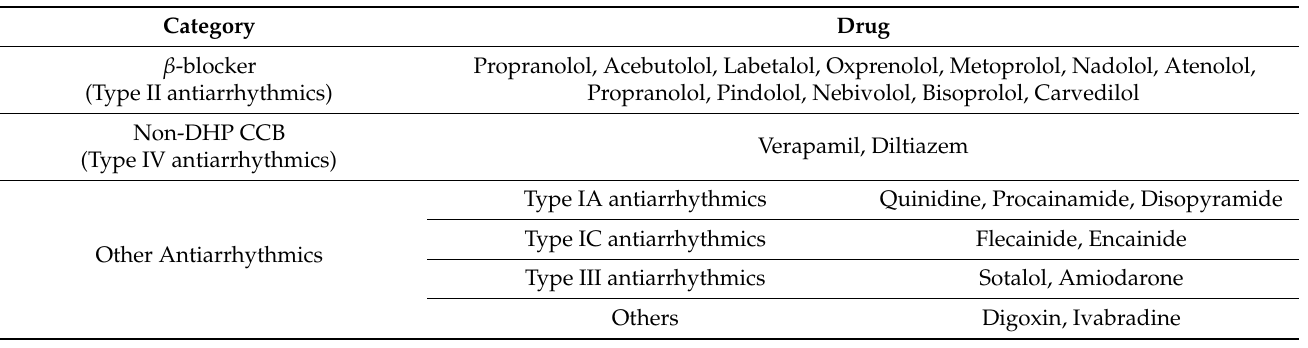
Table A1. List of the potential medications affecting ECG